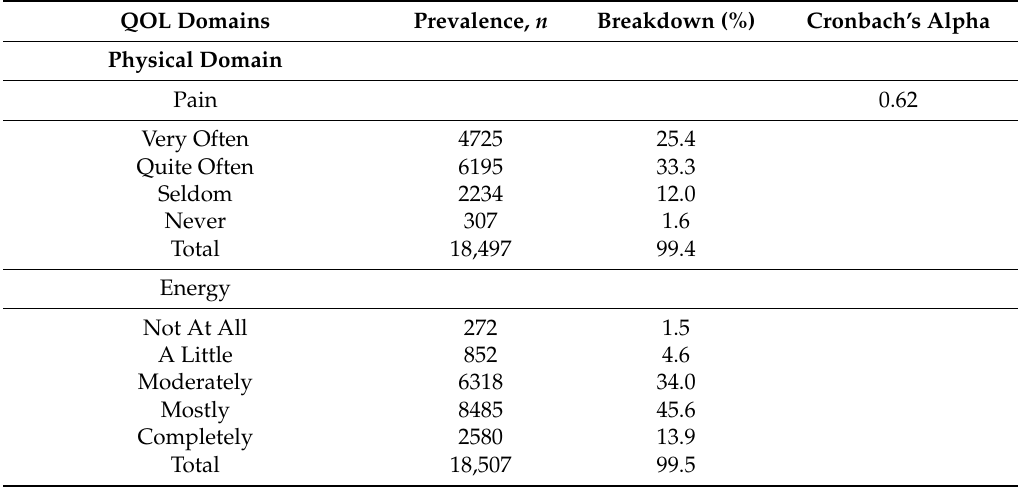
Table A1. Characteristics of items within each quality of life (QOL)